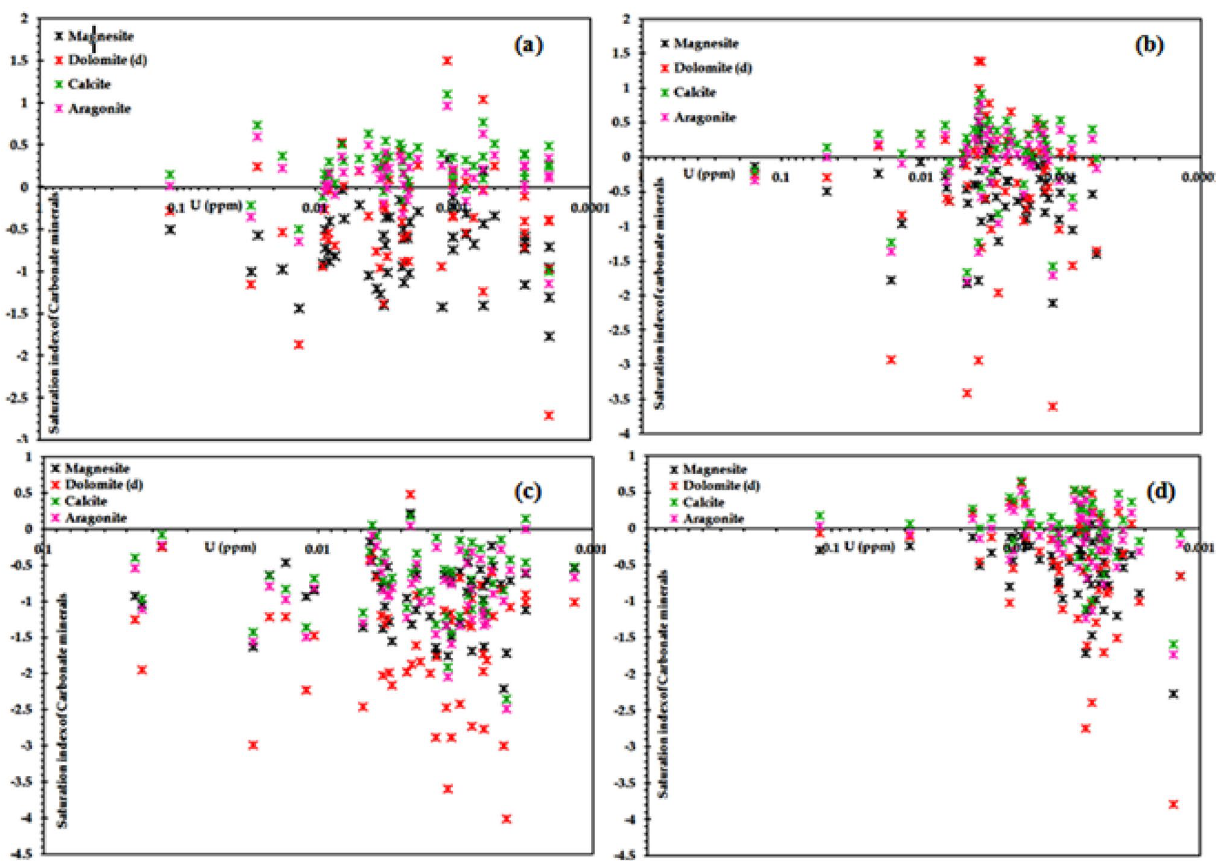
Fig. 14 Variation of Saturation index of different Carbonate minerals with total uranium for samples collected during a PRM, b SWM, c NEM, d